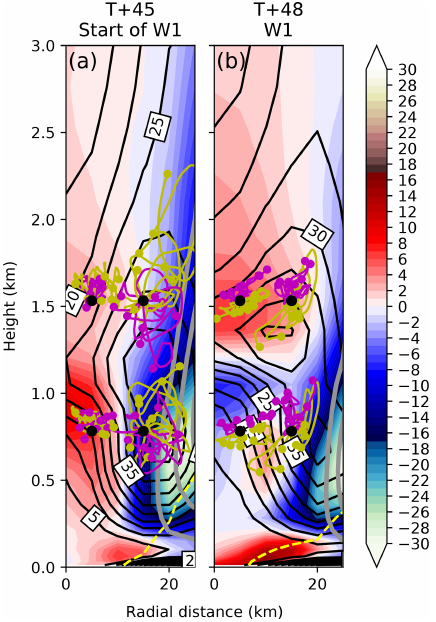
Figure 8. Change in PV over the past hour due to advection only (shaded, PVUh − 1 ). Black line contours show the PV field in inter- vals of 5PVU. Additionally, four sets of trajectories are shown for the following ( r , z ) points (black scatter points): (5km, 1532m), (15km, 1532m), (5km, 782m), and (15km, 782m). Purple lines and scatter points represent the forward trajectory over the next hour, while mustard lines and scatter points represent the backward trajectory over the previous hour. Each set of trajectories contains eight points going back or forward with the same radial distance from the storm centre but with different azimuthal angles around the storm centre: to the east, northeast, north, northwest, west, south- west, south, and southeast of the storm centre. The grey contours show vertical velocity (ascent) in 0.25ms − 1 intervals, indicating the location of the inner eyewall. The dashed yellow line shows the − 1ms − 1 inflow